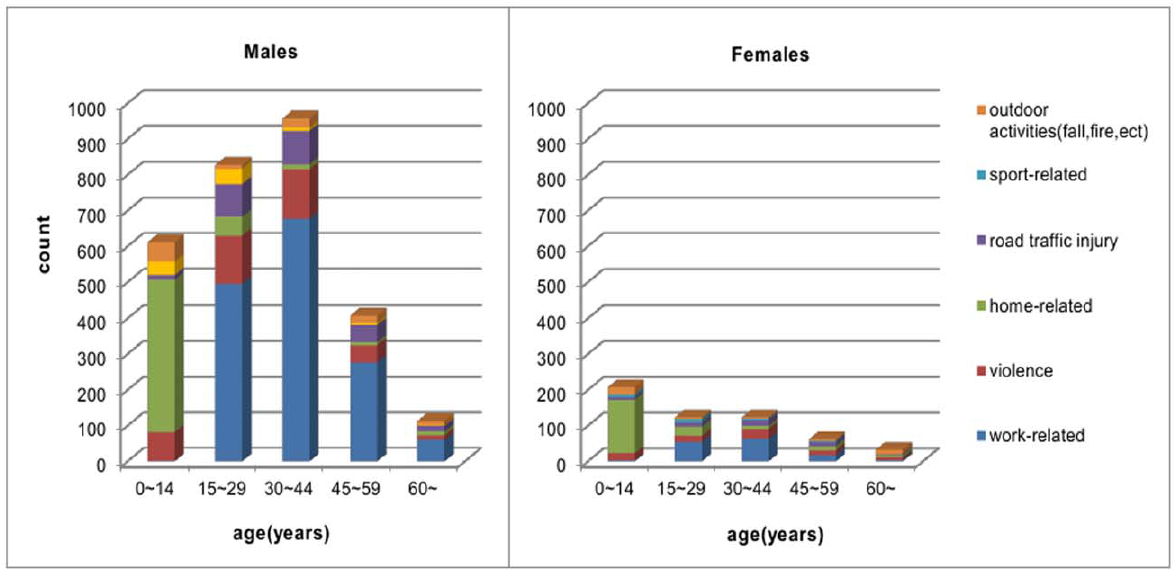
Figure 1. Frequency of types of eye injuries by age and gender. The majority of injuries (56.2%) occurring in males were distributed in the 15–44 age groups; the most frequent injury cause were related to work (70.0%), violence (16.3%), and road traffic (6.2%). The majority of injuries (36.0%) occurring in females were distributed in the 0–14 age group; the most frequent injury cause were related to the home (72.1%), violence (9.6%), and sports (3.8%).